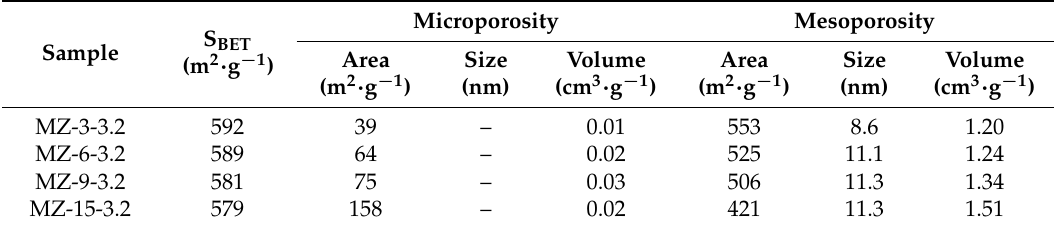
Table 1. Pore parameters of the